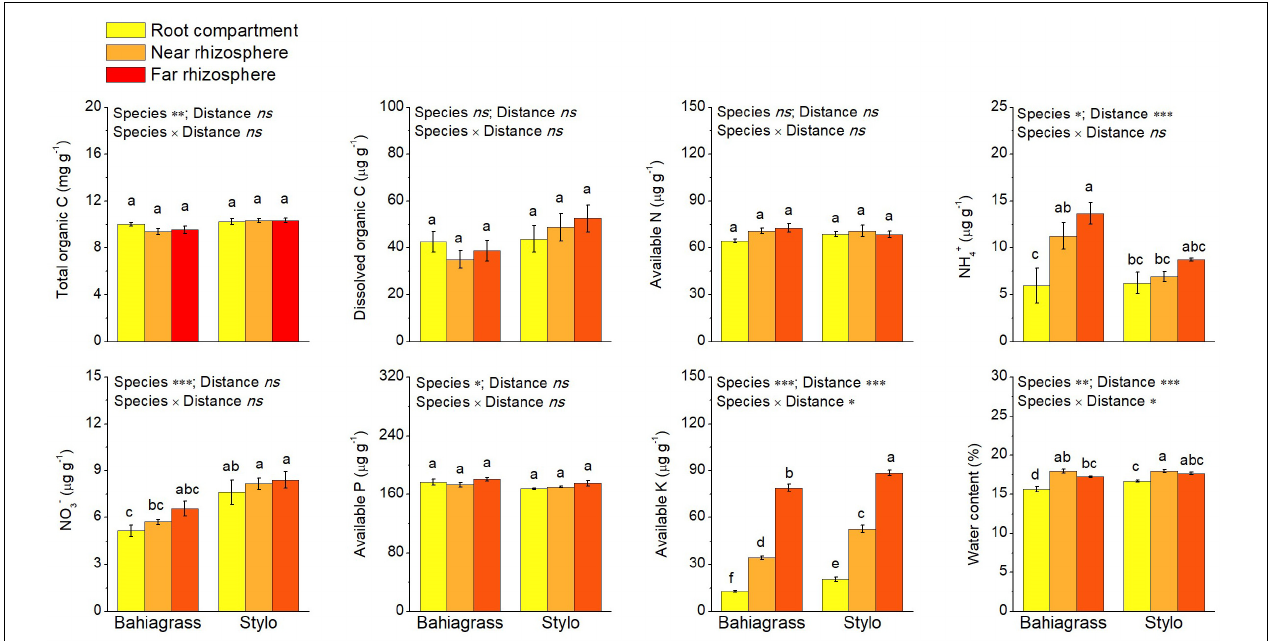
FIGURE 1 | Soil chemical properties as affected by plant species and distance. Bars with different letters are significantly different (Tukey HSD test, P < 0.05). Near rhizosphere and far rhizosphere indicate the rhizosphere space of 0–5 mm and 10–15 mm apart from rhizoplane, respectively. Bahiagrass, Paspalum natatum ; Stylo, Stylosanthes guianensis